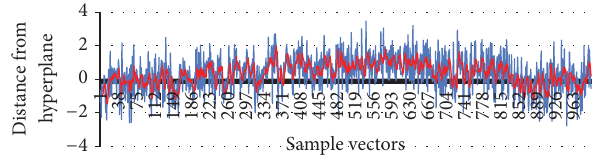
Figure 11: State drift of TOM DICK HARRY (TDH) over time based on “state strength.” The slower variant shows a 5-sample moving average.